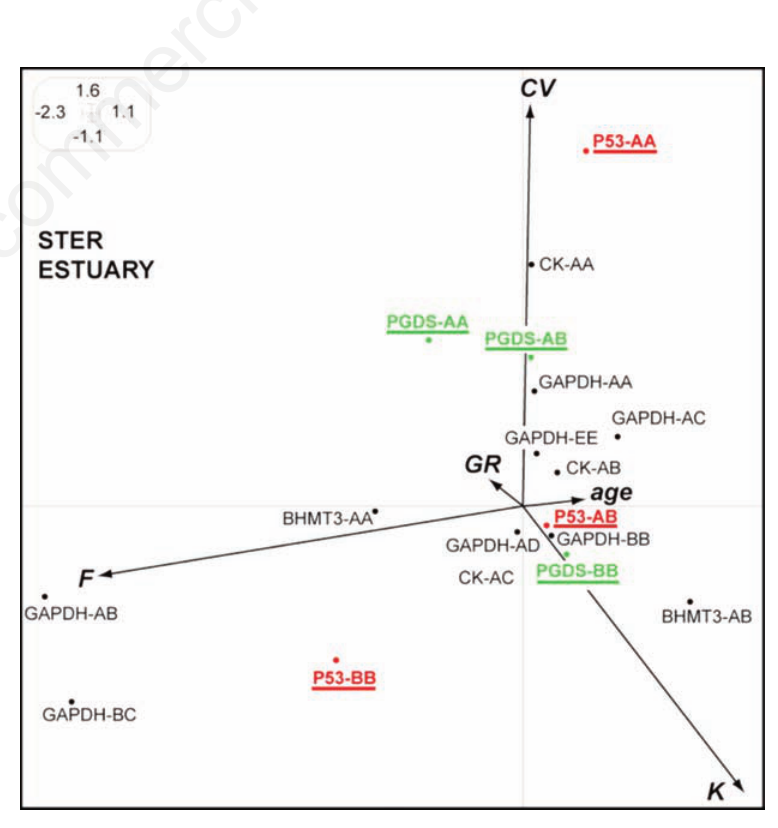
Figure 5. Synthetic Hill and Smith analysis for European flounders from the Ster estuary. The main 2 first axes explain 44% of the total variance. See Figure 1 caption for